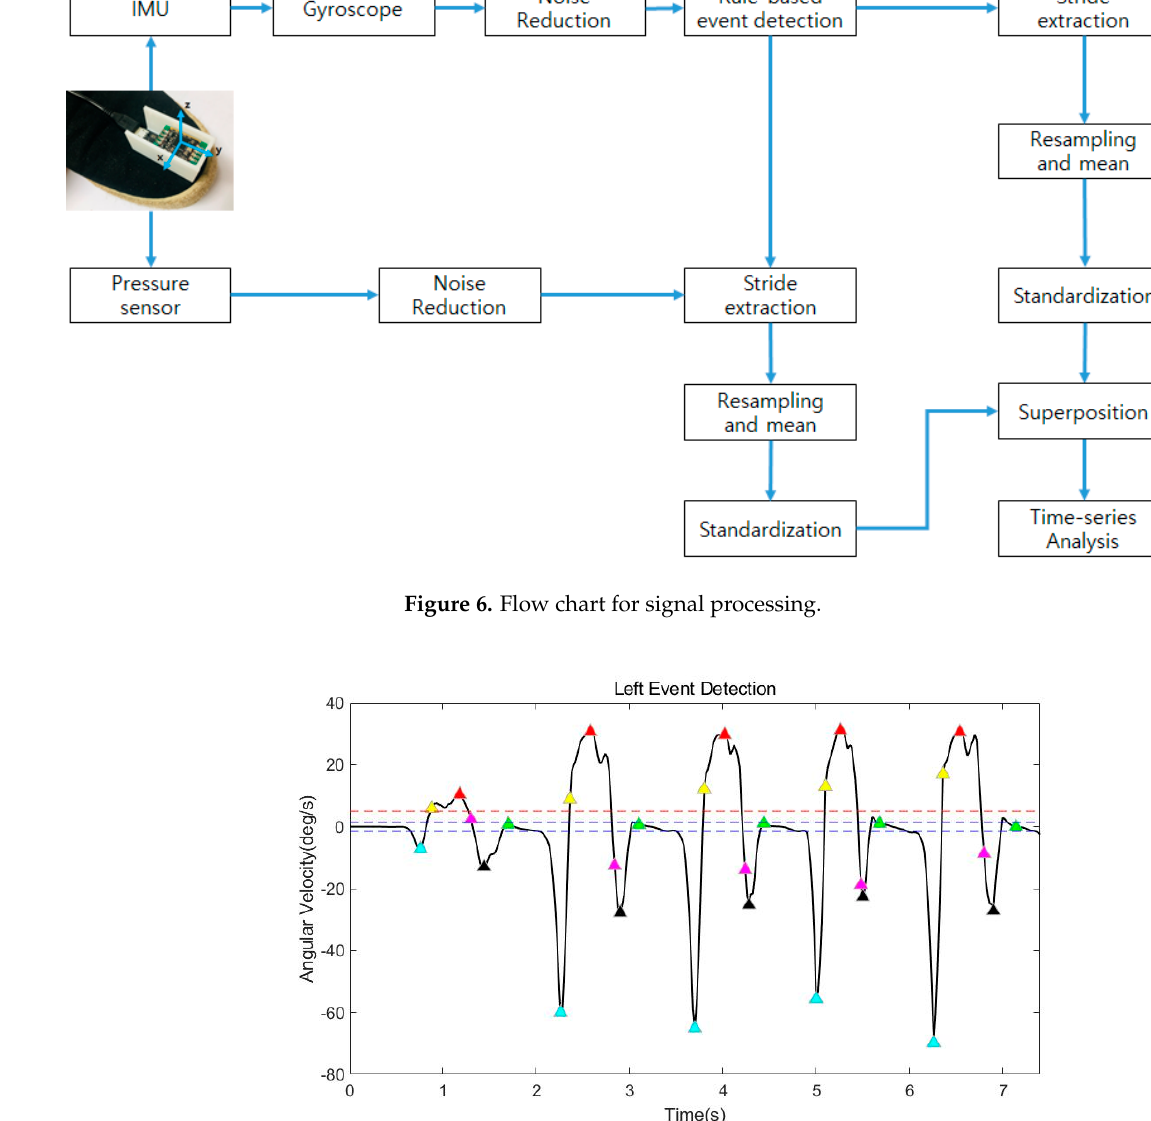
Figure 7. The result of gait event detection.